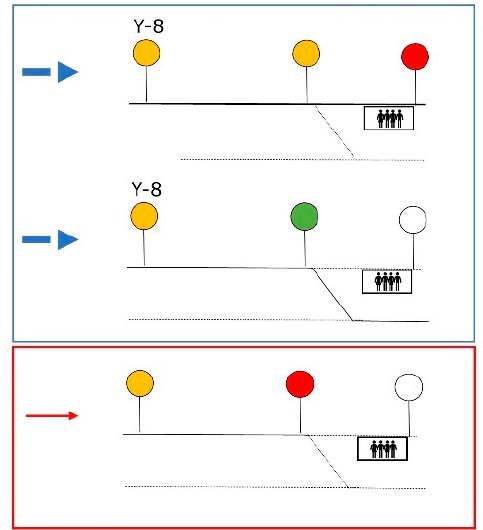
Figure 9. The yellow aspect in the deviating approach (bottom) is at the same location as the yellow:number aspect during the standard approach because of the entrance at station and/or the upcoming switch (top). During both approaches, the cue is visually similar (yellow vs. yellow:number) and the location is the same. Note: Both yellow:number aspects must be the same during the blue approaches.